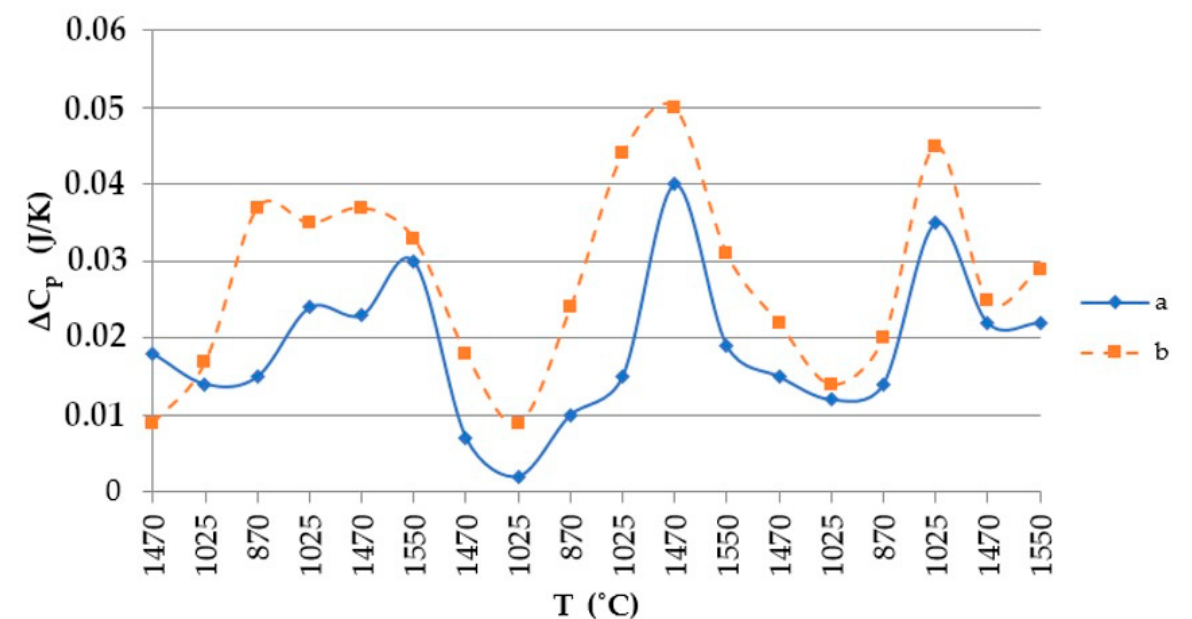
Figure 8. Thermal temperature dependence graph: a, quartzite treated at 200 °C; b, quartzite treated at 800 °C. The values of the heat capacity in each melting cycle were selected, and graphs of their changes were constructed. These are presented as fragments of thermograms in Figures 9–14 for each type of quartzite.